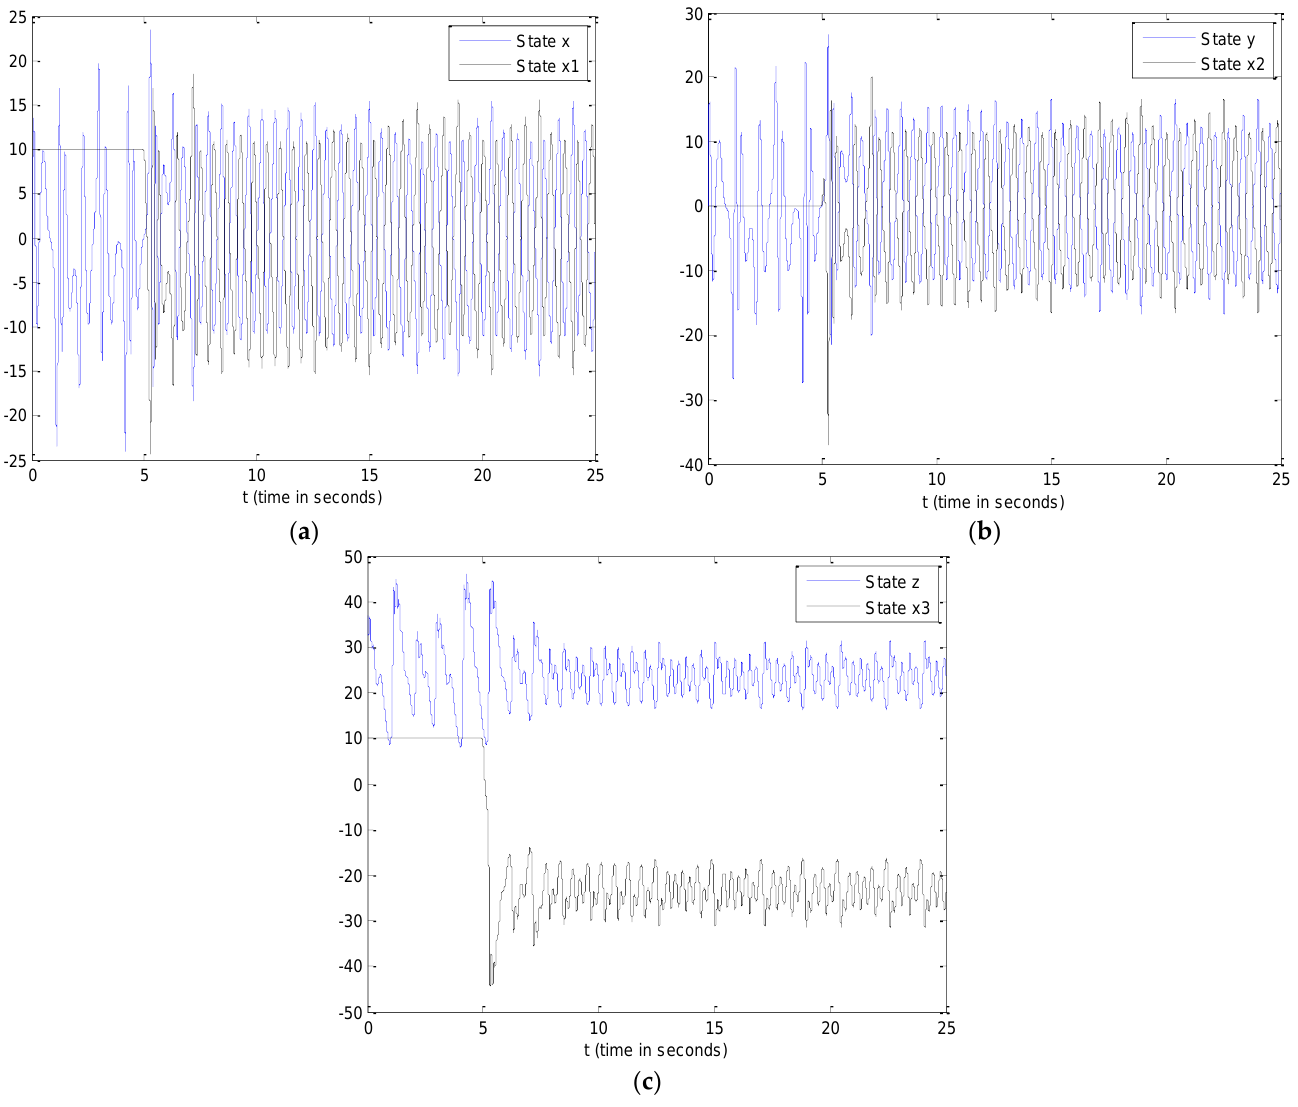
Figure 14. Fractional order derivative with 𝛼 = 0.9, 0.8,and 0.5 and time delay 𝜏 = 5 s. Time response plots of time-delay anti-synchronized states of master and slave: ( a ) First state (𝑥 − 𝑥1) of master and slave; ( b ) second state (𝑦 − 𝑥2) of master and slave; ( c ) third state (𝑧 − 𝑥3) of master and slave.